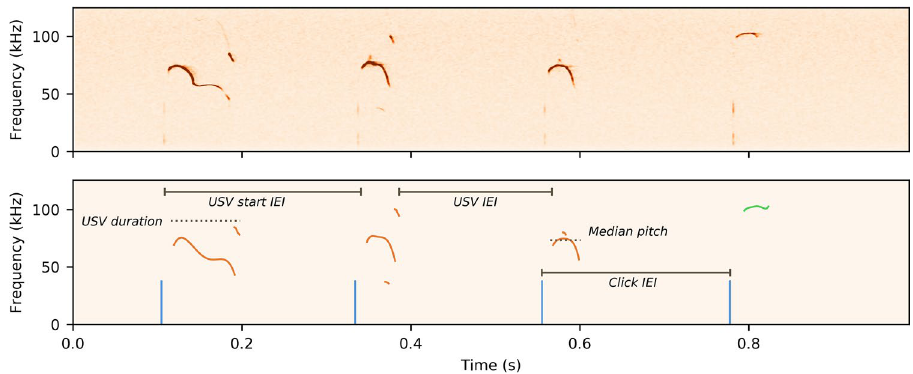
Figure 1. A visual representation of the analysis of the USV recordings. Top: an example trace from a healthy mouse. Bottom: the same data after extraction and processing. Multi-component vocalizations are indicated in brown, and simple vocalizations are indicated in green. Blue vertical lines are the locations of clicks. We calculate three forms of inter-event intervals (IEIs): USV end to USV start IEIs, USV start to USV start IEIs and click